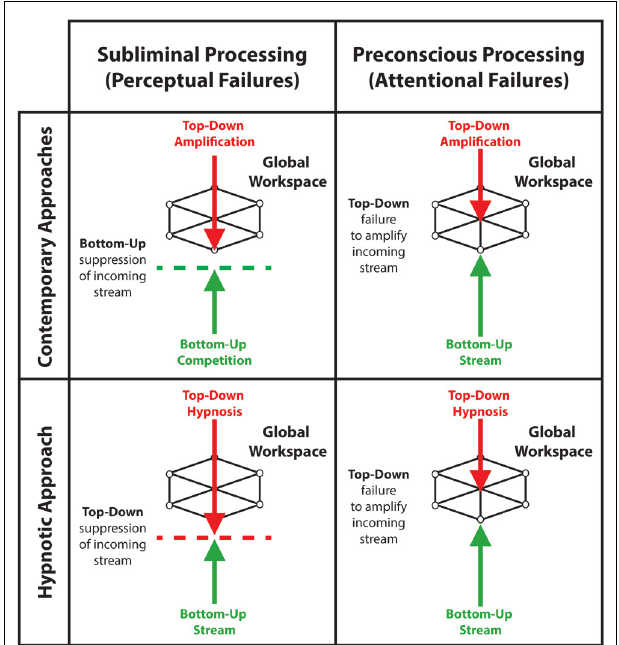
FIGURE 1 | Contemporary approaches and the hypnotic approach as a function of the taxonomy that differentiates subliminal processing, reflecting perceptual failures, from preconscious processing, reflecting attentional failures. During subliminal processing : contemporary approaches utilize bottom-up competition between sensory inputs to exploit the limits of perception, prevent global broadcast of incoming signals and induce conscious suppression; while the hypnotic approach harness top-down processes to modulate lower perceptual processes and suppress sensory inputs. During preconscious processing : both contemporary approaches and the hypnotic approach prevent global broadcast by hindering top-down amplification of incoming sensory